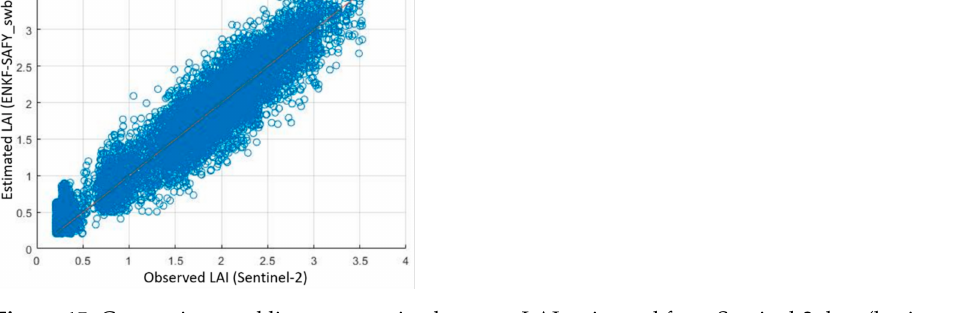
Figure 15. Comparison and linear regression between LAI estimated from Sentinel-2 data (horizontal axes, denominated as obs) and LAI simulated by EnKF-SAFY_swb (vertical axis, denominated as sim) for the whole area of